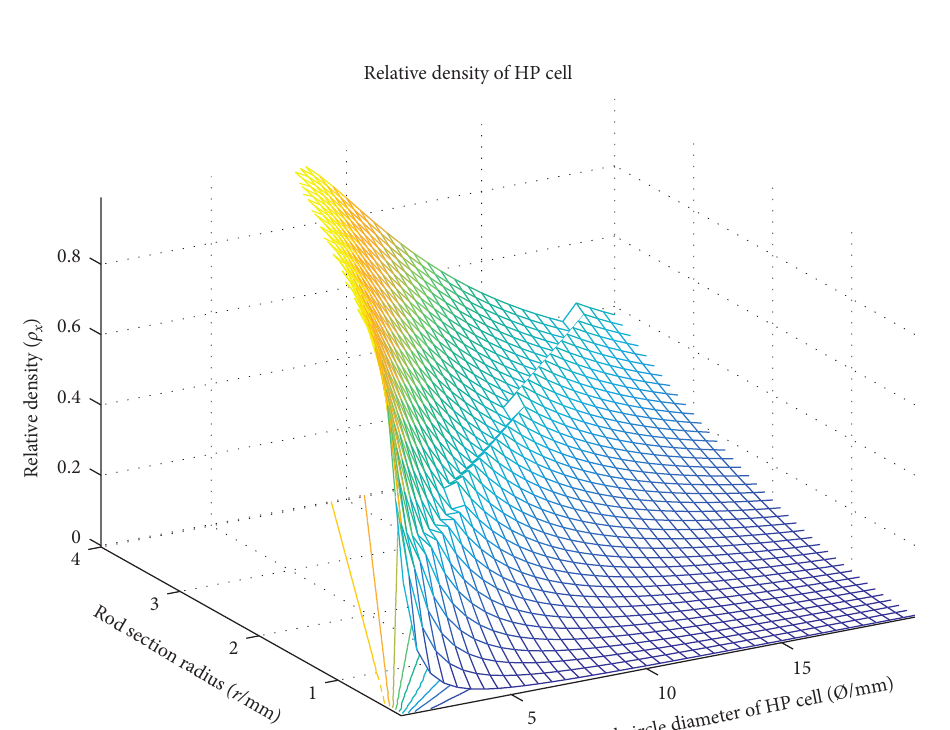
Figure 6: Final results of structure cell relative